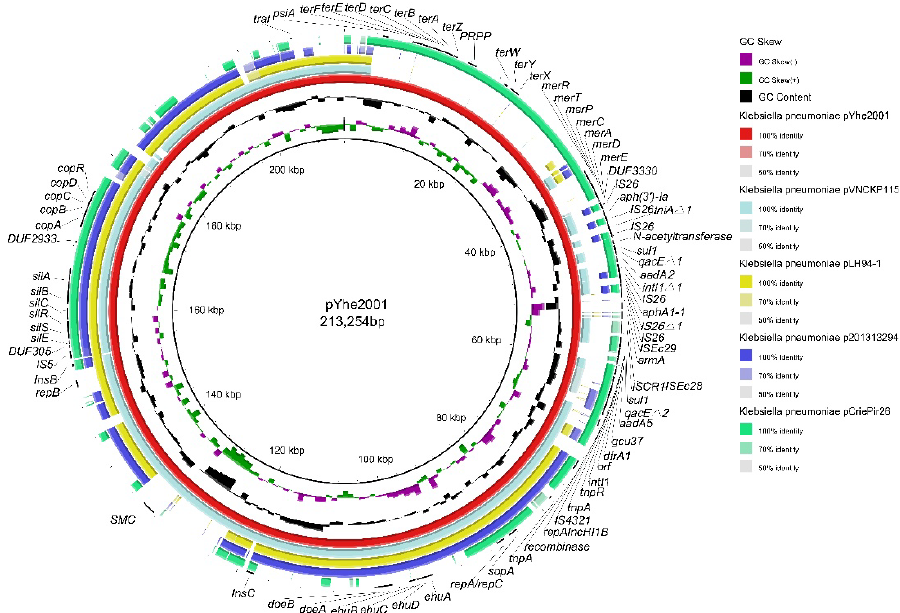
Figure 2. Comparisons of pYhe2001 complete genome sequences with NCBI-published complete plasmid sequences of another four K. pneumoniae strains using BRIG. The innermost circles repre- sent the GC skew (purple/green) and GC content (black). Rings 1–5 represent K. pneumoniae pYhe2001, K. pneumoniae pVNCKp115, K. pneumoniae pLH94-1, K. pneumoniae p201313294, K. pneumo- niae pCriePir26,